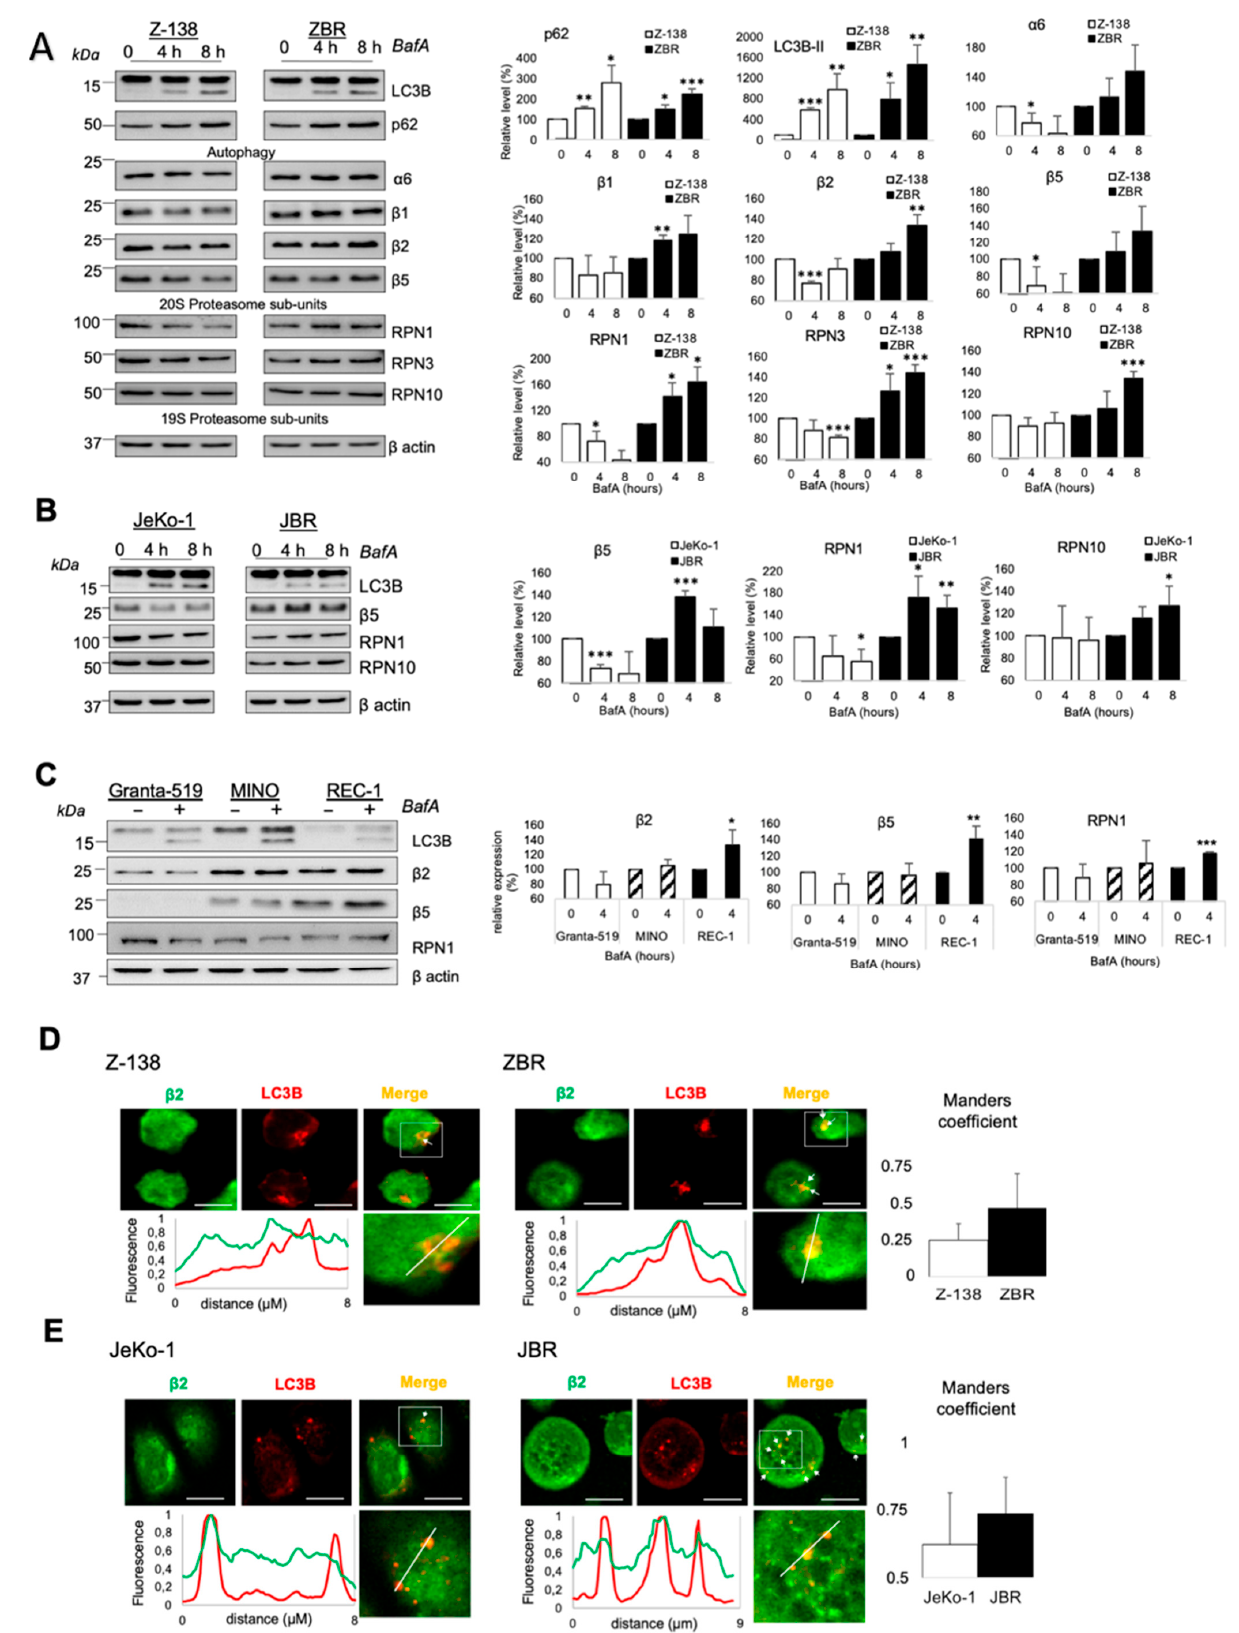
Figure 2. Proteaphagy is activated in BTZ-resistant MCL cells. BTZ-sensitive cells Z-138 ( A ) and JeKo-1 ( B ) and their resistant counterparts, ZBR and JBR, were treated with or without 20 nM